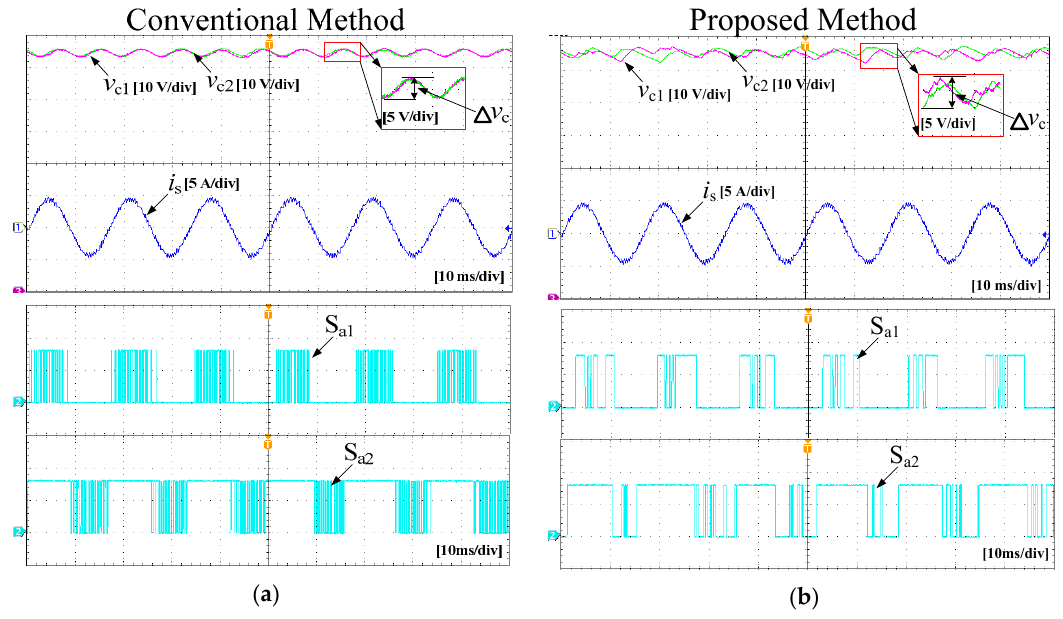
Figure 21. Experimental results of capacitor voltages ( v c1 , v c2 ), source current ( i s ), and upper switch of a leg ( S a 1 , S a 2 ) during steady state in ( a ) conventional method and ( b ) proposed method.